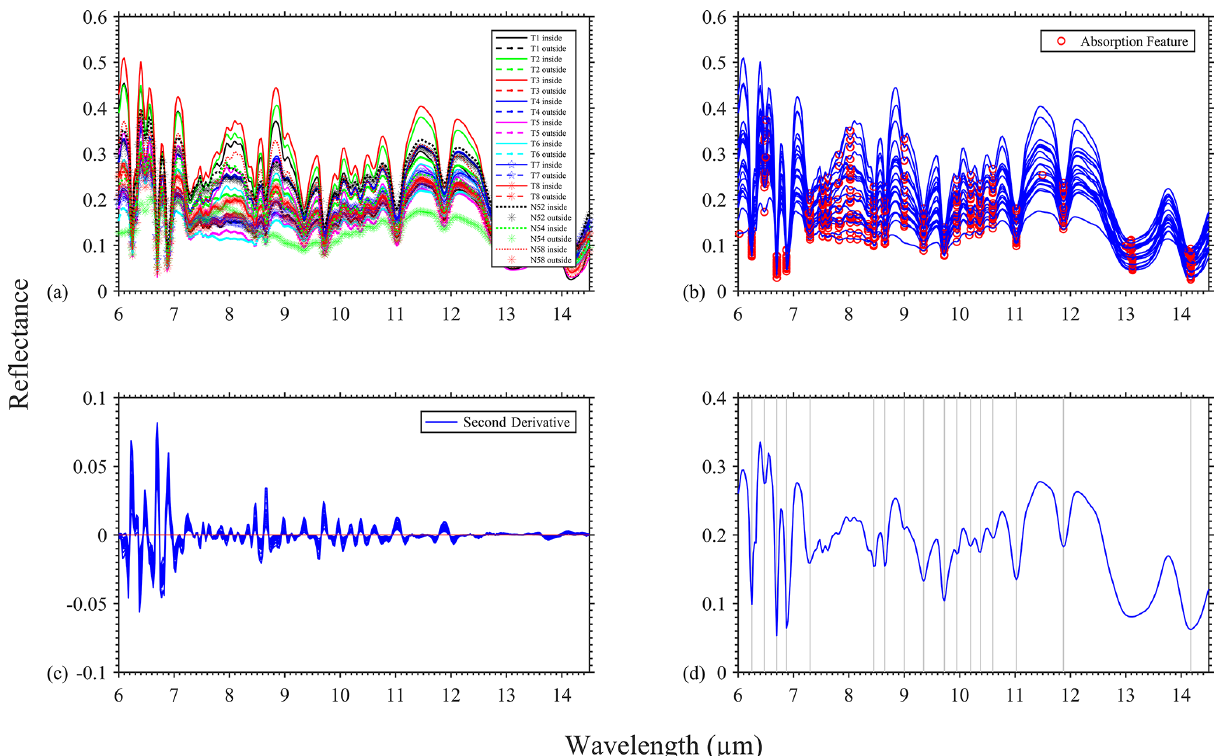
Figure 5. (a) Spectral reflectance of Styrofoam ® pieces found on the shorelines of Punta Mallil-Cuem, Detif and Punta Apabón on the Chiloé Archipelago, Chile; (b) absorption features automatically picked; (c) second-derivative spectra; and (d) an end-member signal with the proposed diagnostic absorption features highlighted by the vertical